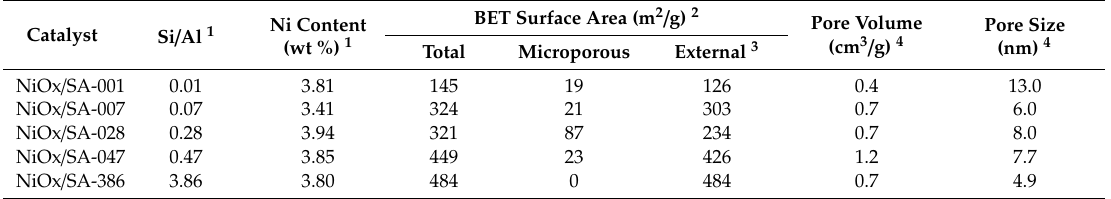
Table 1. Chemical composition and textural properties of the catalysts prepared in this study. Catalyst